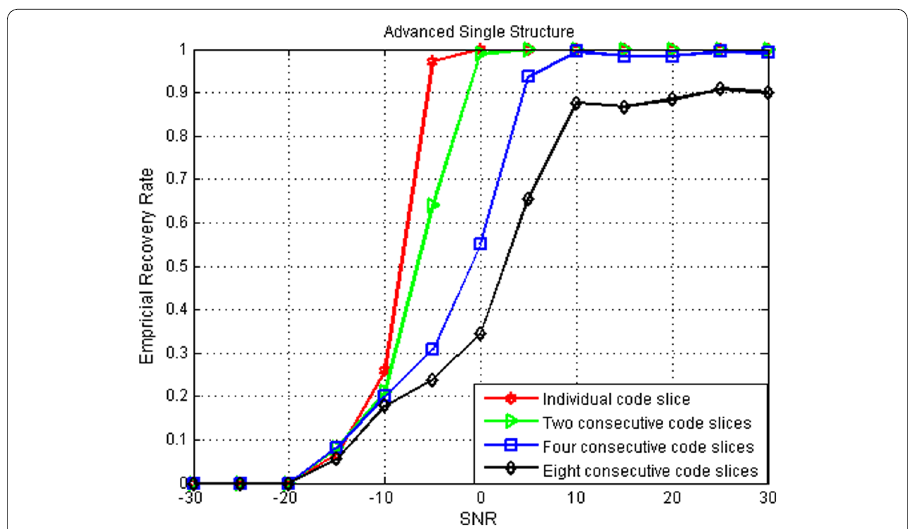
Fig. 14 Percentage of correct support recovery in ADS, when m =